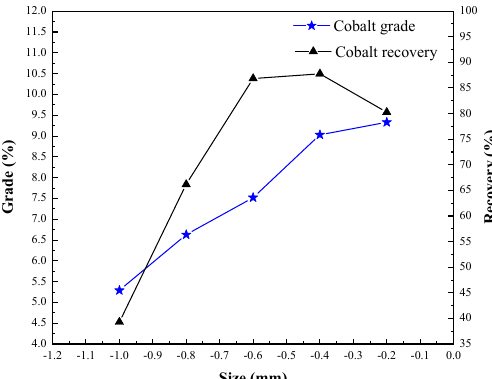
Figure 11. E ff ect of coke size on cobalt extraction. Figure 11. Effect of coke size on cobalt extraction.